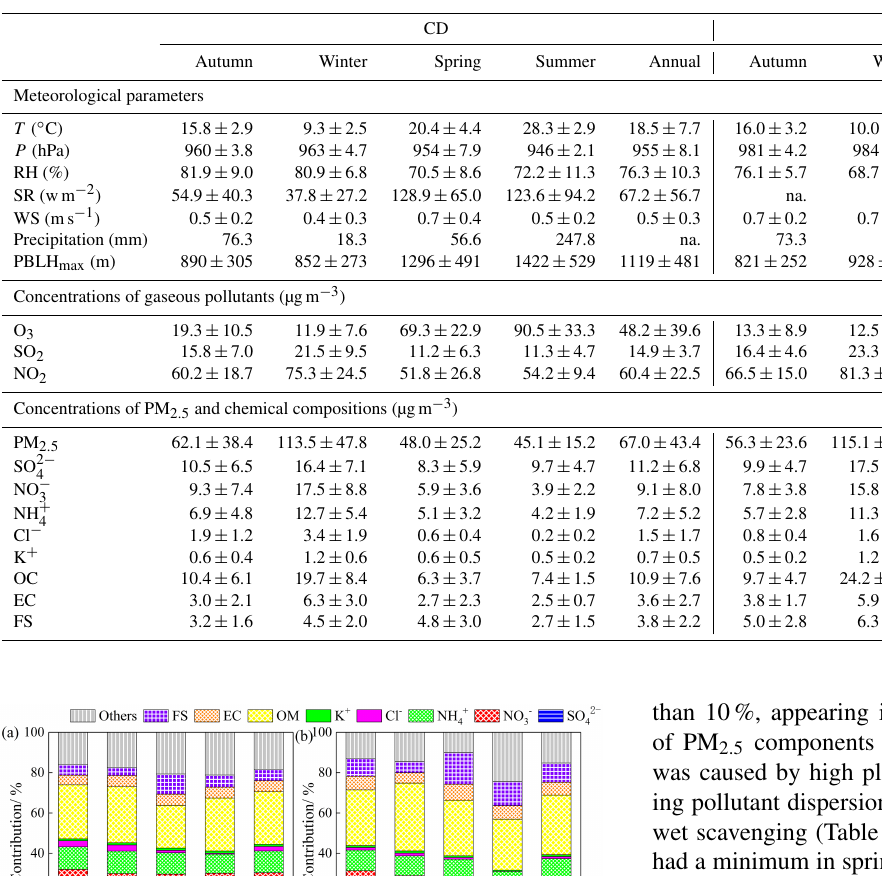
Table 1. Meteorological parameters, annual and seasonal mean concentrations of PM 2 . 5 , gaseous pollutants, and major chemical components at CD and CQ during 2014–2015. na. means no data.